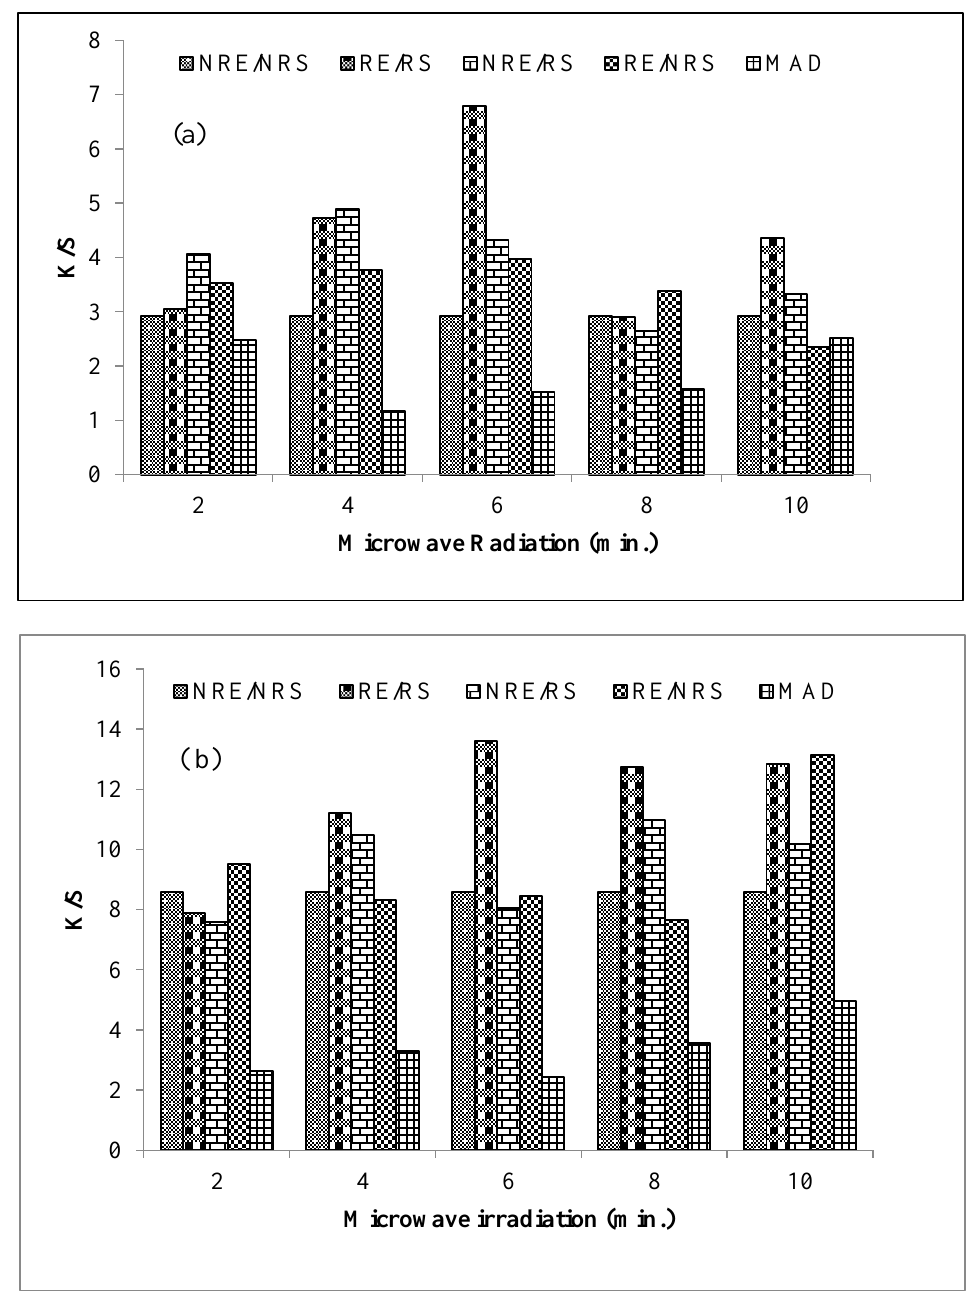
Figure 1. Utilization of microwave-irradiated and un-irradiated aqueous ( a ) and acid extract ( b ) of black pepper for dyeing irradiated and un-irradiated silk